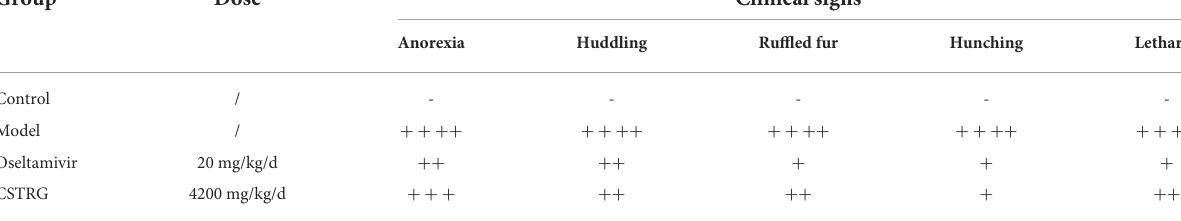
TABLE 1 Assessment of morbidity in mice.